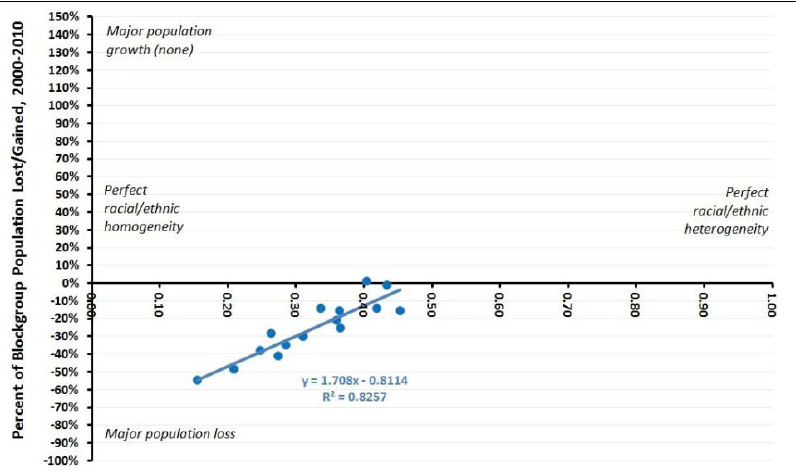
Figure 4. Relationships Between Post-Katrina (2010) Social Diversity and Post-Katrina (2000–2010) Population